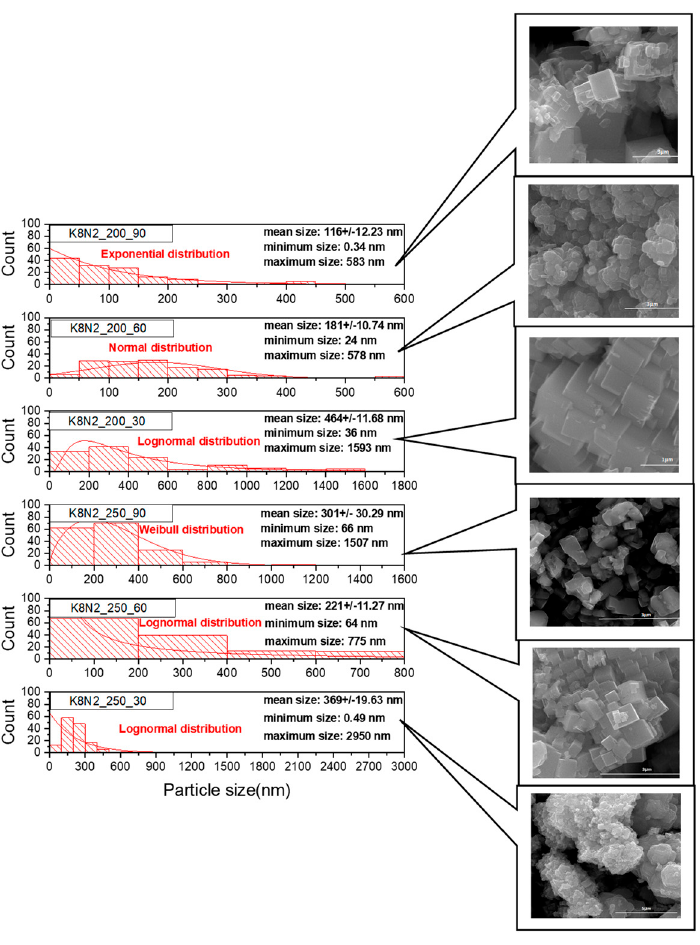
Figure 10. SEM images and particles size distribution for sample series K8N2 after 30–90 min of HTMW at 200 °C and 250 °C.